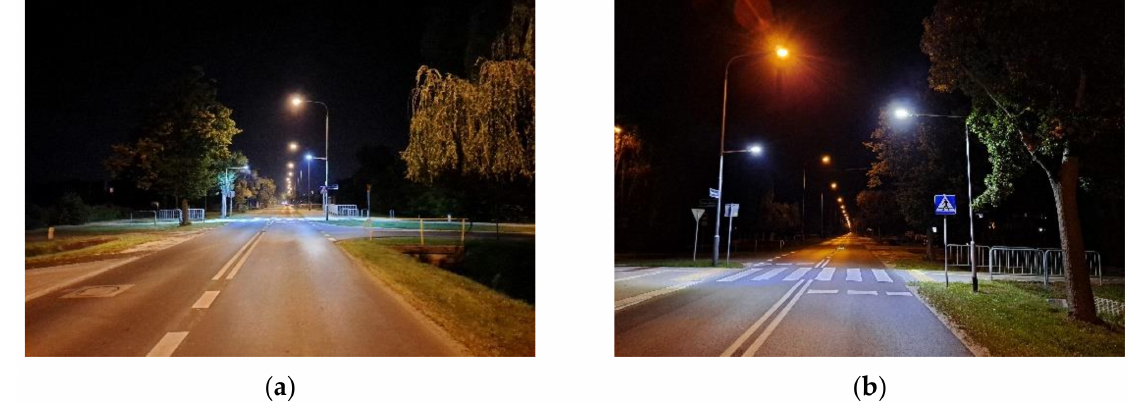
Figure 10. Night-time appearance of pedestrian crossings no. 2, ( a ) one direction of traffic; ( b ) other direction of traffic.